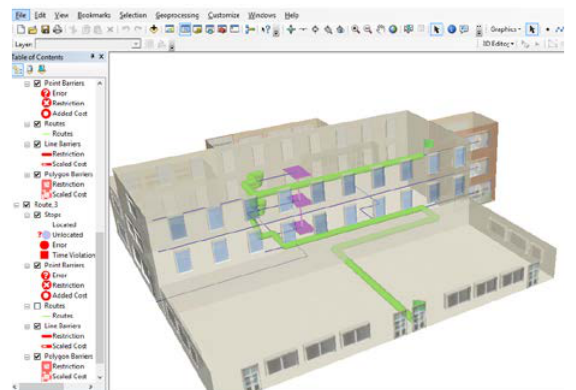
Figure 13. Visualization of the building’s exterior shell and the